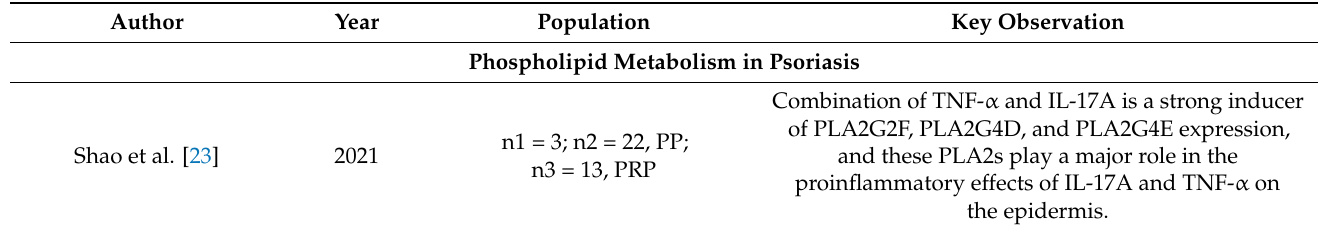
Table 3. Summary of the studies on phospholipid metabolism in